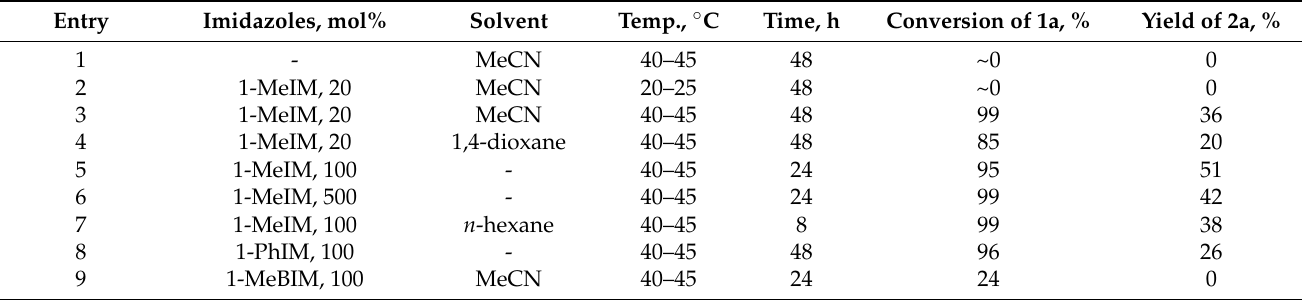
Table 1. Conditions for [3+3]-cyclodimerization of benzoylethynylpyrrole 1a under the action of imidazoles.